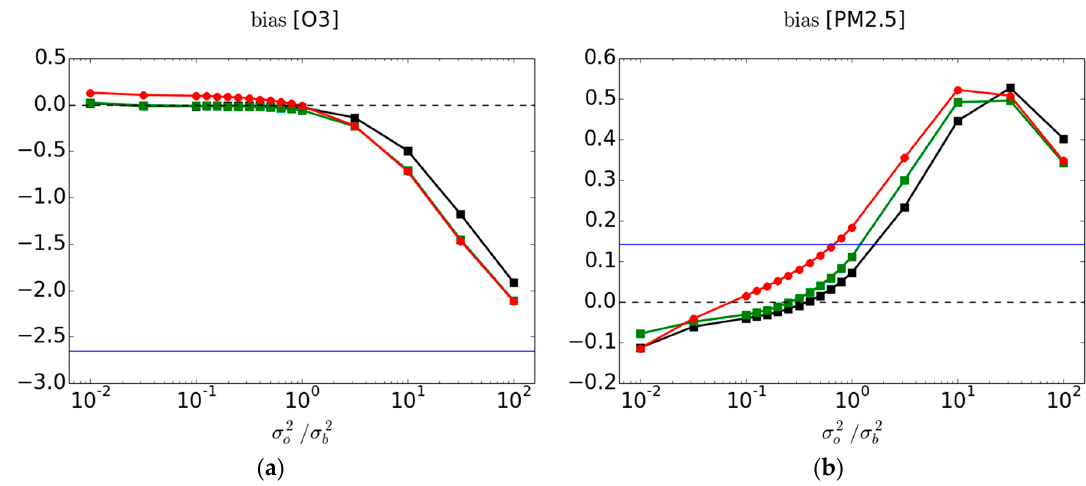
Figure 5. Bias between observation and analysis for ( a ) O 3 and ( b ) PM 2.5 for both active and cross- validation passive observations as a function of 22 / bo σσγ= . The red, black and green curves are as in Figure 2.